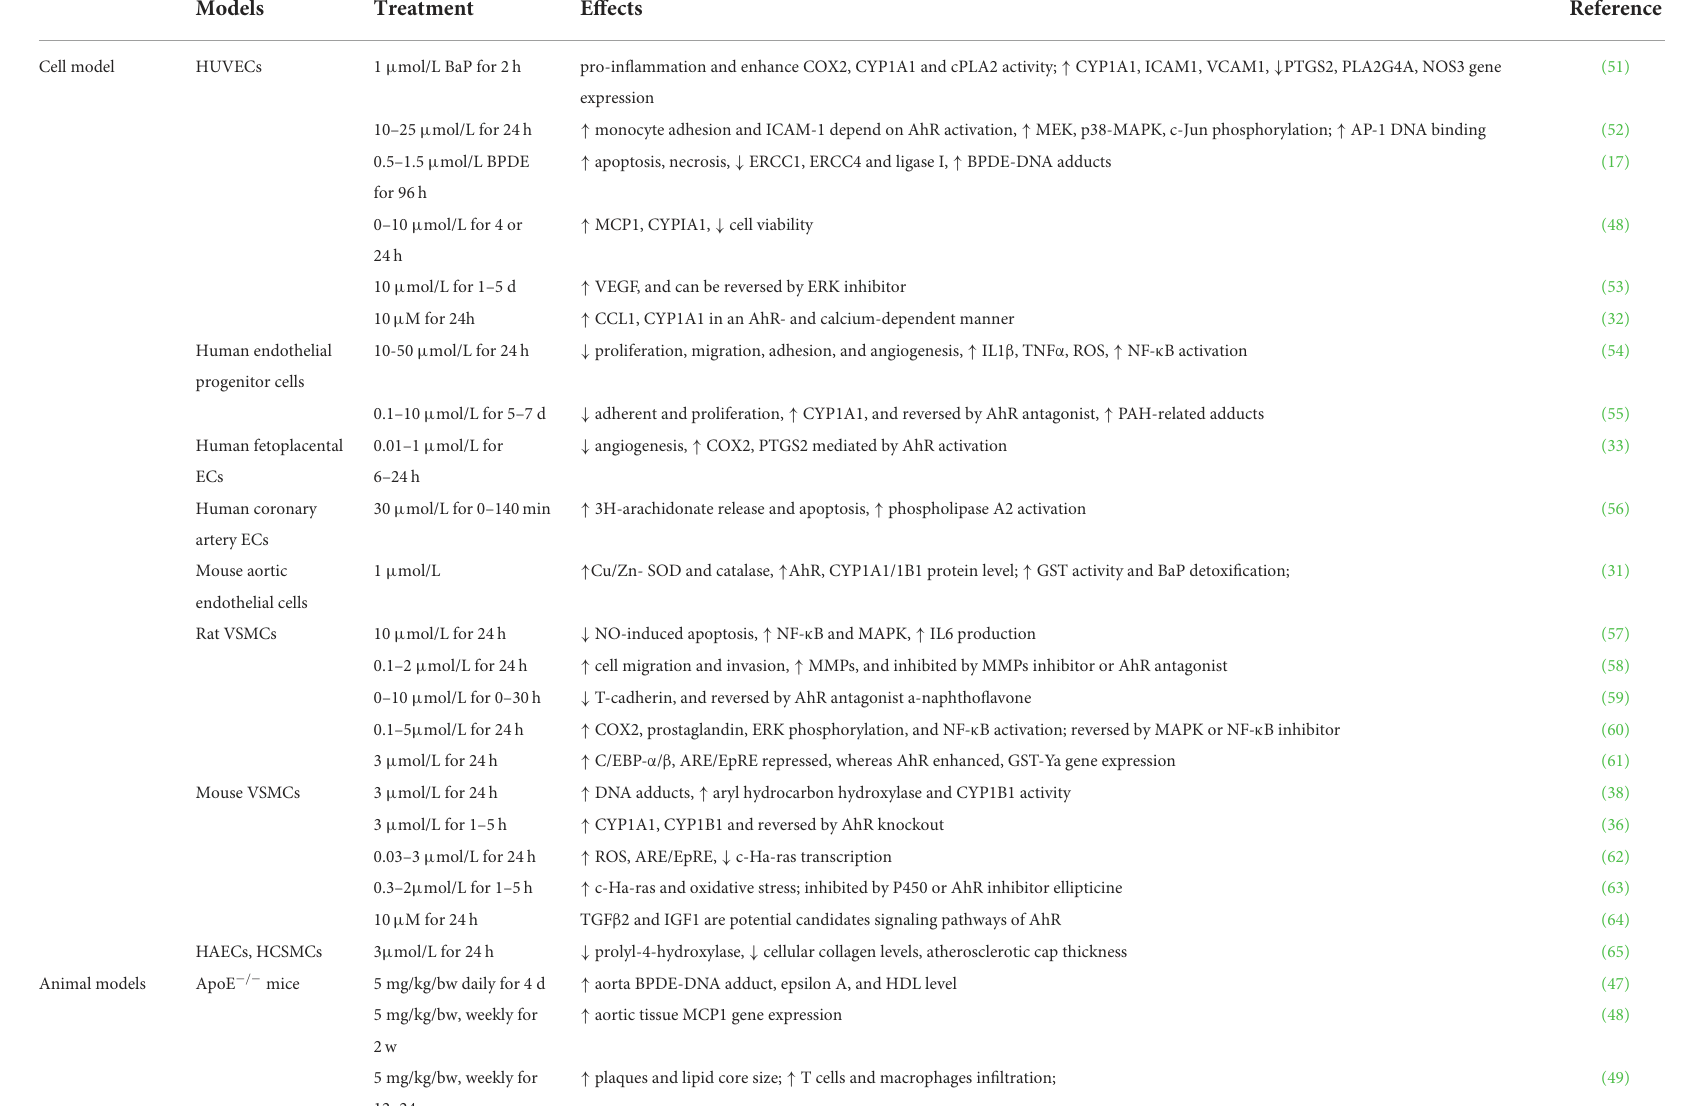
TABLE 1 Effects of BaP on